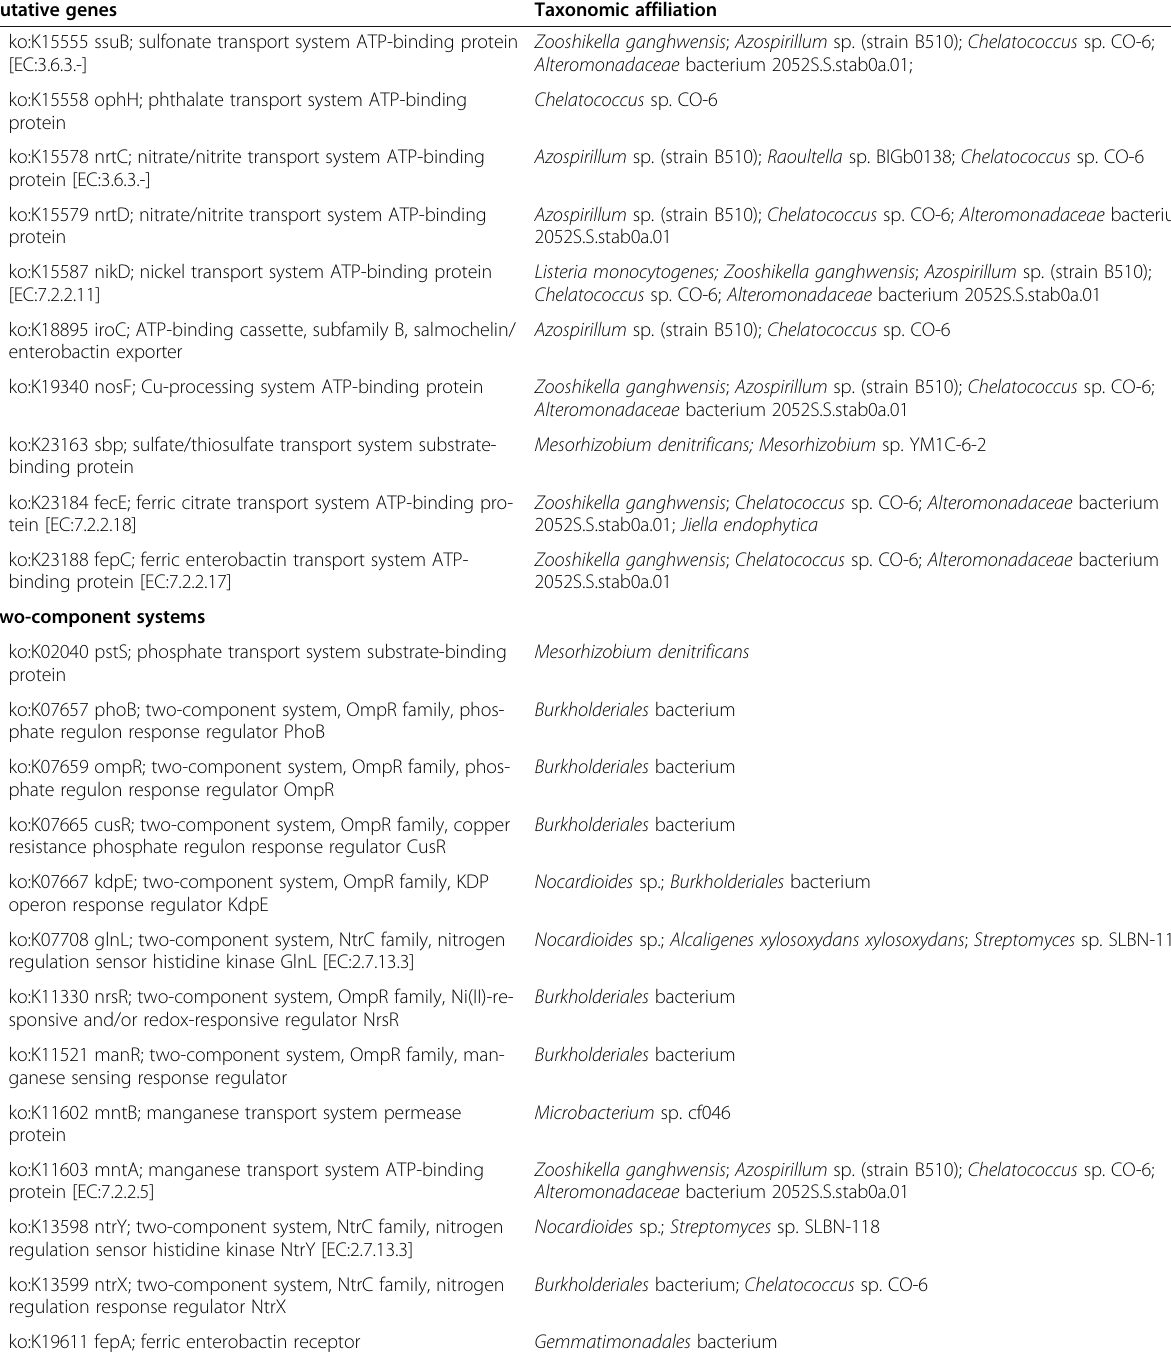
Table 3 Putative genes for ABC transporters and their two-component systems detected in the FN1 metagenome and their taxonomic affiliation